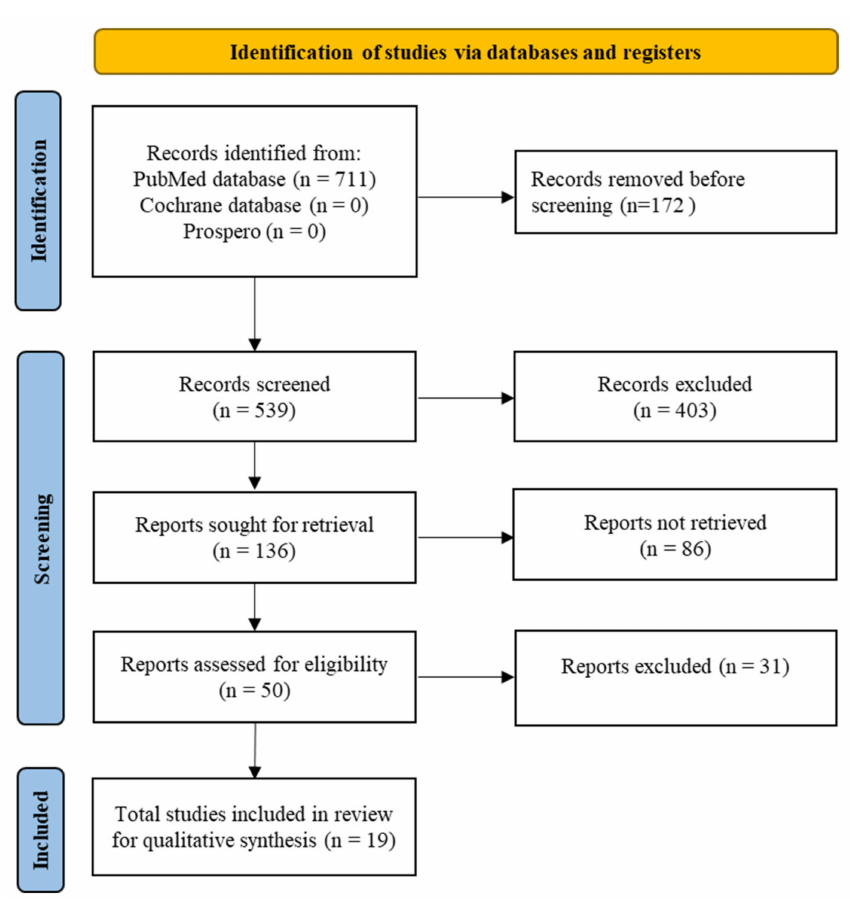
Figure 1. Flow chart for inclusions.